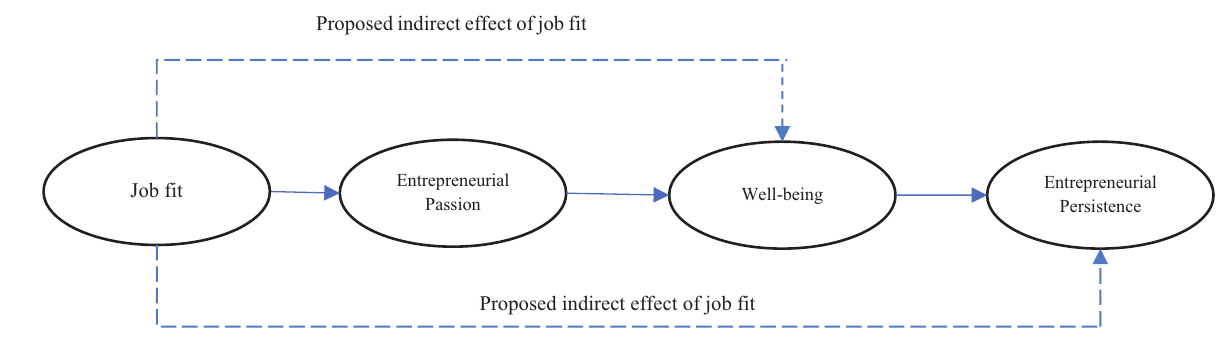
FIGURE 1 | Conceptual